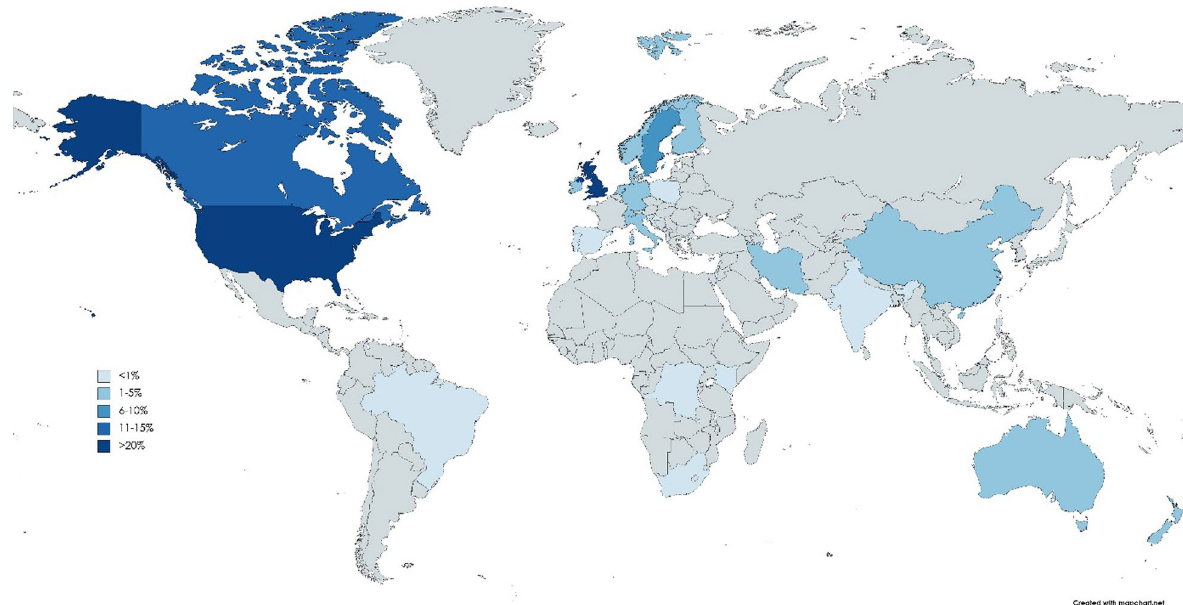
Fig. 3 Overview of the articles (% of total) that include pediatric patient engagement per